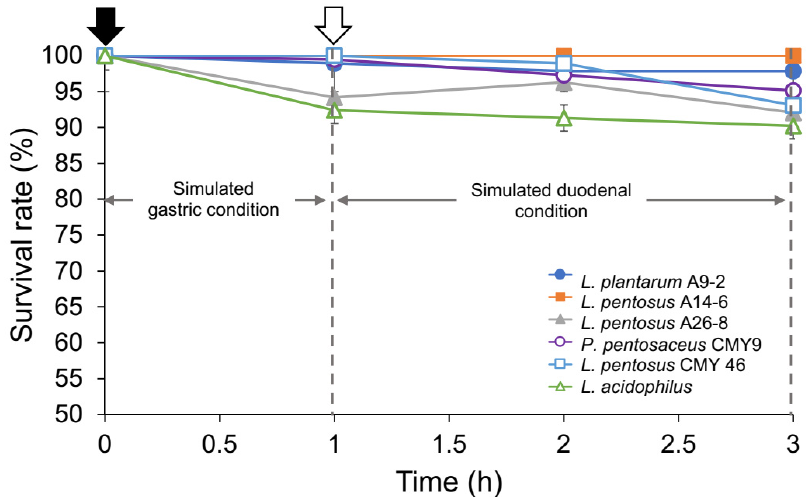
Figure 3. Survival of L. plantarum A9-2, L. pentosus A14-6, L. pentosus A26-8, P. pentosaceus CMY9, L. pentosus CMY46, and L. acidophilus under simulated gastrointestinal conditions. Black and white arrows indicate addition of simulated gastric juice and simulated duodenal juice, respectively.